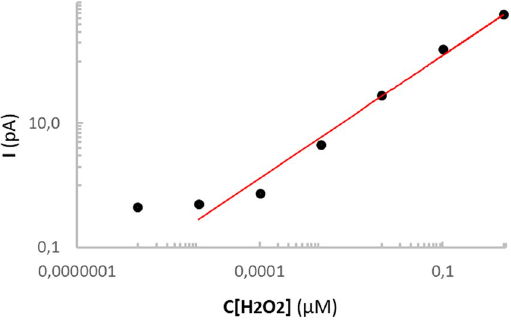
Figure 3. Dose response curve of the oxidation of hydrogen peroxide by the platinized nanoelectrode (at + 800 mV vs Ag/AgCl).